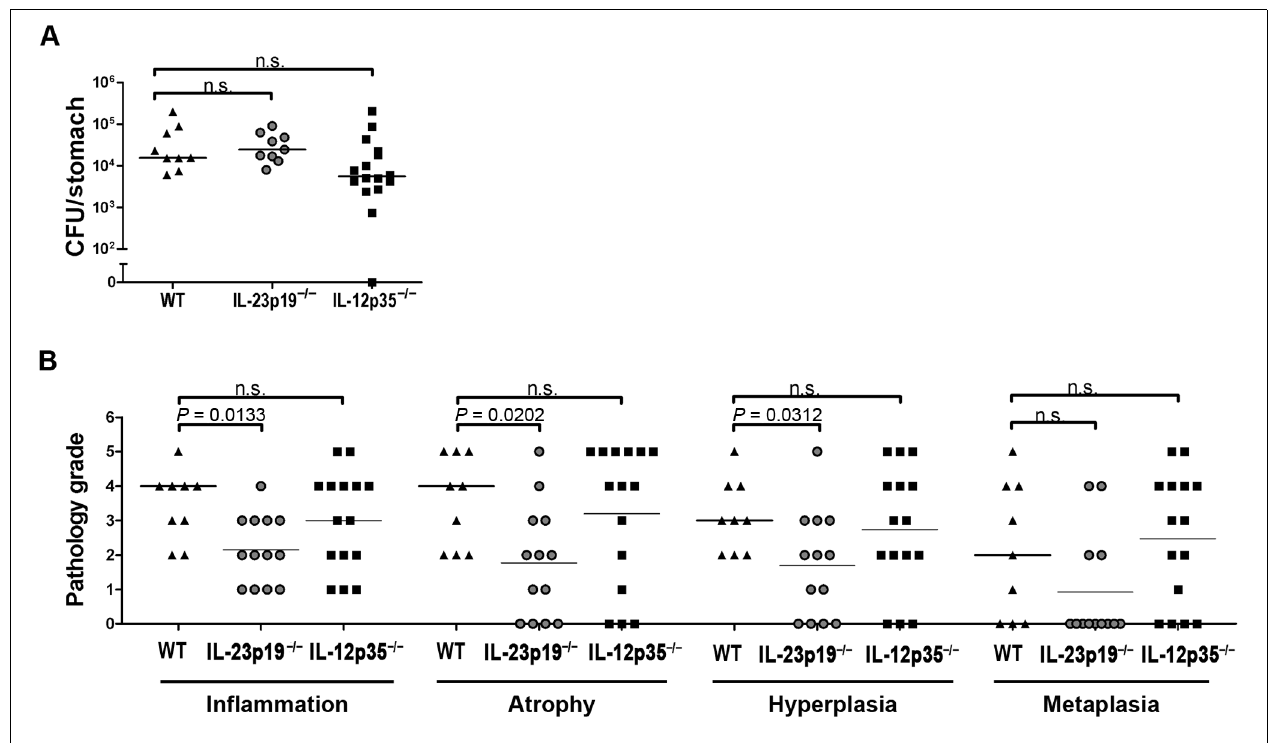
infected with H. pylori strain PMSS1 for 3 months. Note that of the 13 infected IL-23p19 − / − animals, only 9 were available for colony counting. (B) Histopathology scores assigned to every mouse shown in (A) for all indicated parameters on a scale of 0–6. Medians are indicated by horizontal lines; each symbol represents one mouse. Data are from two pooled